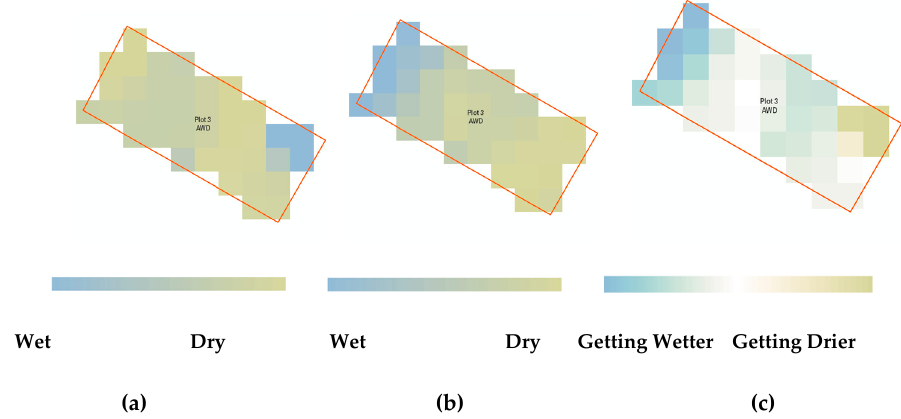
Figure 3. Change detection approach. ( a ) Initial time step wetness index (WI) scores for Test Plot 3, used in this figure as an example to illustrate the variability within each rice paddy, as well as its change over time. ( b ) The second time step in Test Plot 3, showing the wet and dry patterns changing over time. ( c ) Average change over time is shown, with bluer values illustrating a wetting trend and tan values illustrating a drying trend.